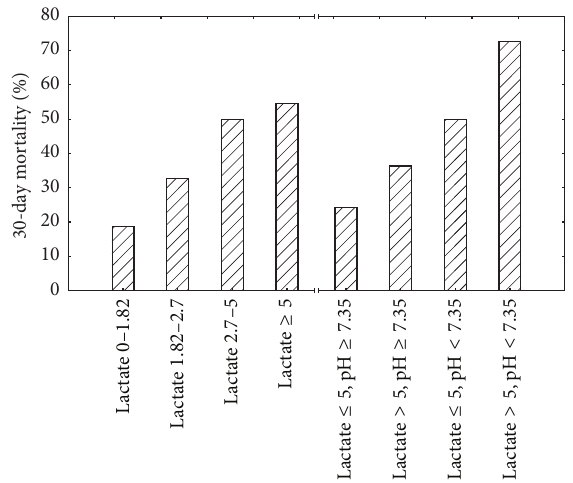
Figure 3: 30-day mortality for different lactate intervals and levels of pH at Medical Emergency Team calls ( 𝑛 = 211